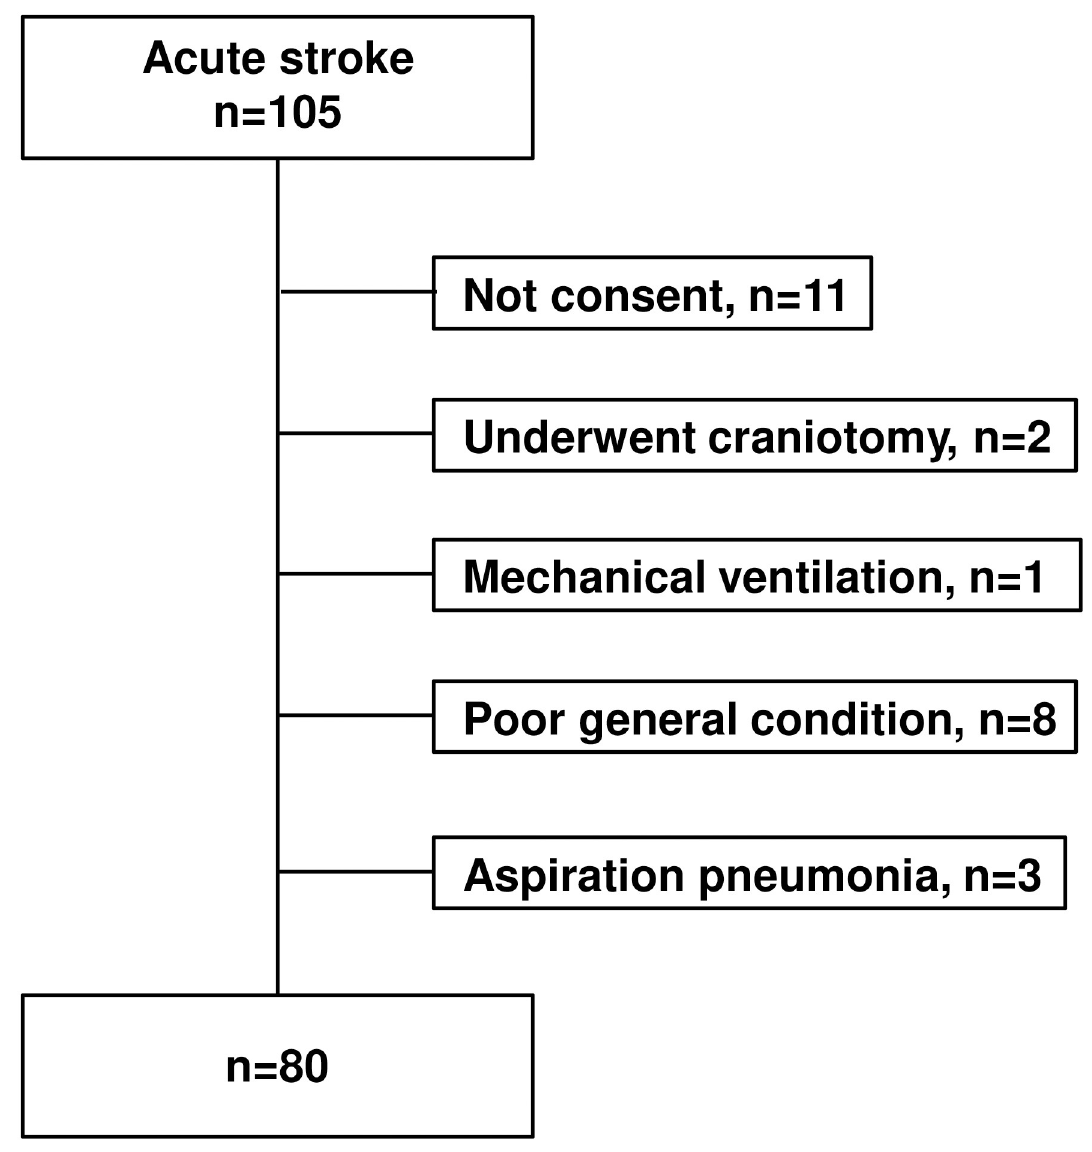
Fig 1. Flow chart of the inclusion and exclusion